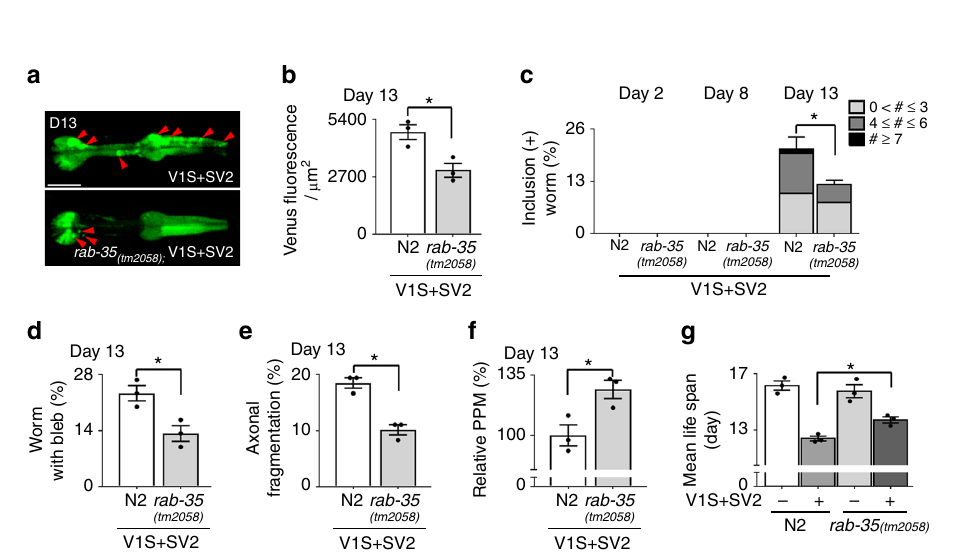
Fig. 5 Mutation in rab-35 resulted in the similar phenotypes as lrk-1 . a, b Venus BiFC fl uorescence in wild-type and rab-35 transgenic models at day 13. The red arrowheads point to Venus BiFC-positive inclusions in pharynx. Twenty worms for each line were used ( N = 3 in each group), * p < 0.05, Scale bars: 200 μ m. c Worms with Venus BiFC-positive inclusions were quanti fi ed at the different ages. The color bars in graph ( c ) indicate percentages of Venus BiFC-positive inclusions. Thirty worms for each line were used ( N = 3 in each group), * P < 0.05. d Quanti fi cation of worms that have axonal blebs. e Nerve fragmentation of each transgenic line at day 13. f Relative pharyngeal pumping rates at day 13. Thirty worms for each line were used ( N = 3 in each group), * p < 0.05. All error bars represent SEM, P value, * p < 0.05, was measured by unpaired, two-tailed Student ’ s t test. g Mean life span. One hundred worms for each line were used ( N = 3 in each group). F(3, 9) = 33.730, P value, * p < 0.05, was calculated by one-way ANOVA with Tukey's post hoc test. All values are represented as mean ± SEM